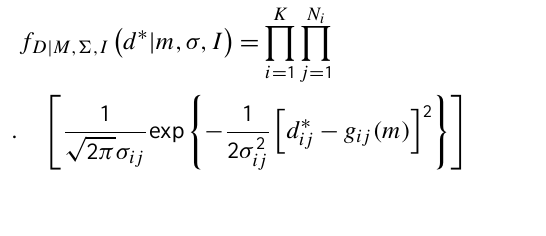
texture classes using the USGS soil texture triangle. Mean = 0.02 for clay, 0.07 for sandy clay, 0.18 for silt, 0.27 for coarse sand; bounds are ± 50% of the mean for the given soil